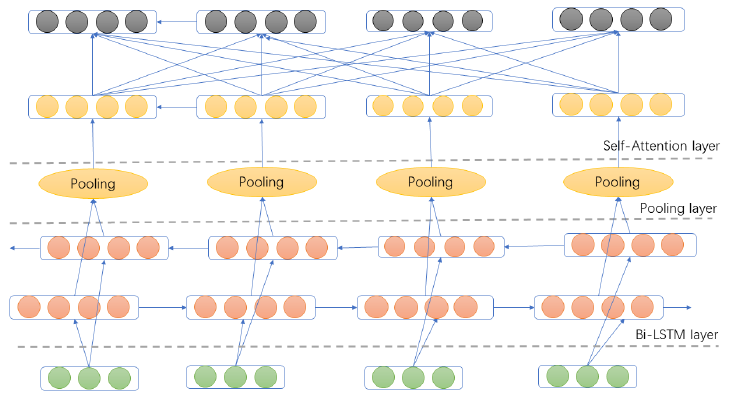
Figure 4. This is the framework of the Bi-LSTM_ATT moudle, which mainly contains three nerual network layers: Bi-LSTM layer, Pooling layer and Self-Attention